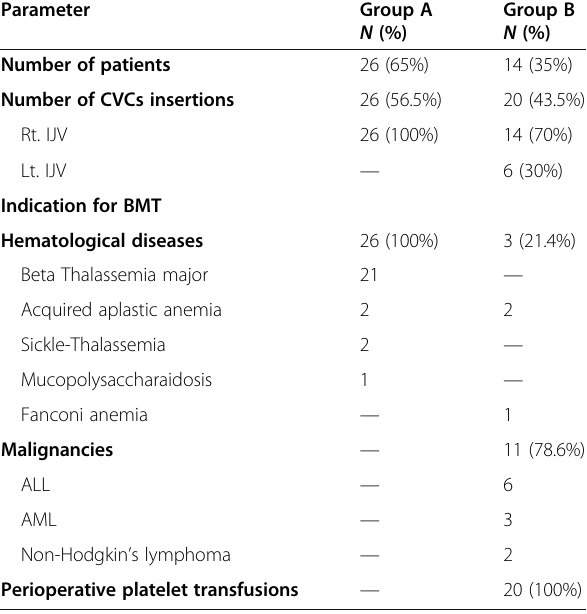
Table 1 The patients ’ clinical characteristics in both groups